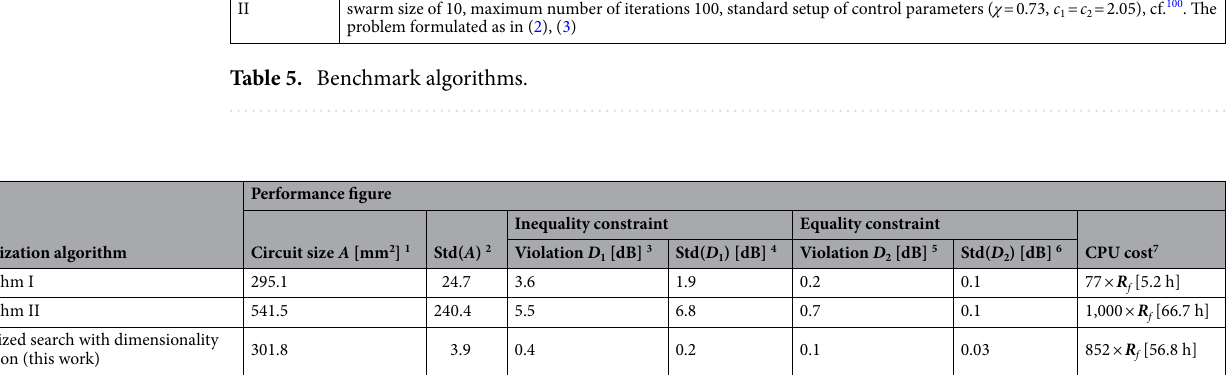
Table 6. Optimization results for Circuit I. 1 Optimized footprint area of the circuit averaged over ten algorithm runs. 2 Standard deviation of the optimized footprint area averaged over ten algorithm runs.